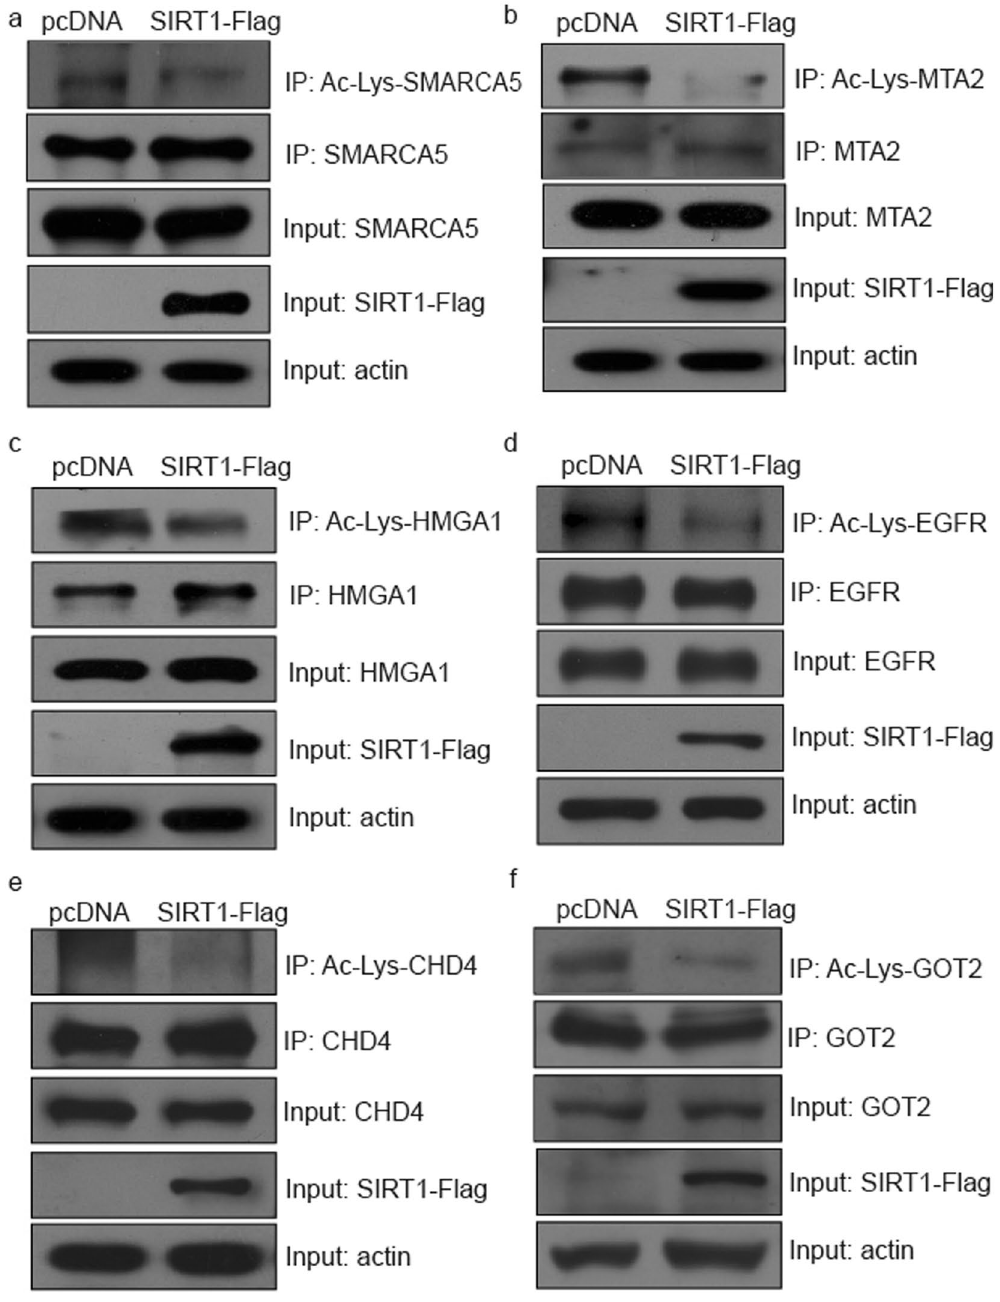
Figure 6. ( a – f ) Detection of predicted deacetylation substrates by SIRT1 with immunoprecipitation and Western blotting. Acetylation levels of SMARCA5 ( a ), MTA2 ( b ), HMGA1 ( c ), EGFR ( d ), CHD4 ( e ) and GOT2 ( f ) decreased after SIRT1 overexpression. pcDNA: pcDNA-vector transfection. SIRT1-Flag: Flag-tagged SIRT1 plasmid transfection as indicated in the figure. Equal amounts of indicated proteins were immunoprecipitated, followed by western blotting with pan-lysine acetylation antibody, used to detect the acetylation of immunoprecipitated